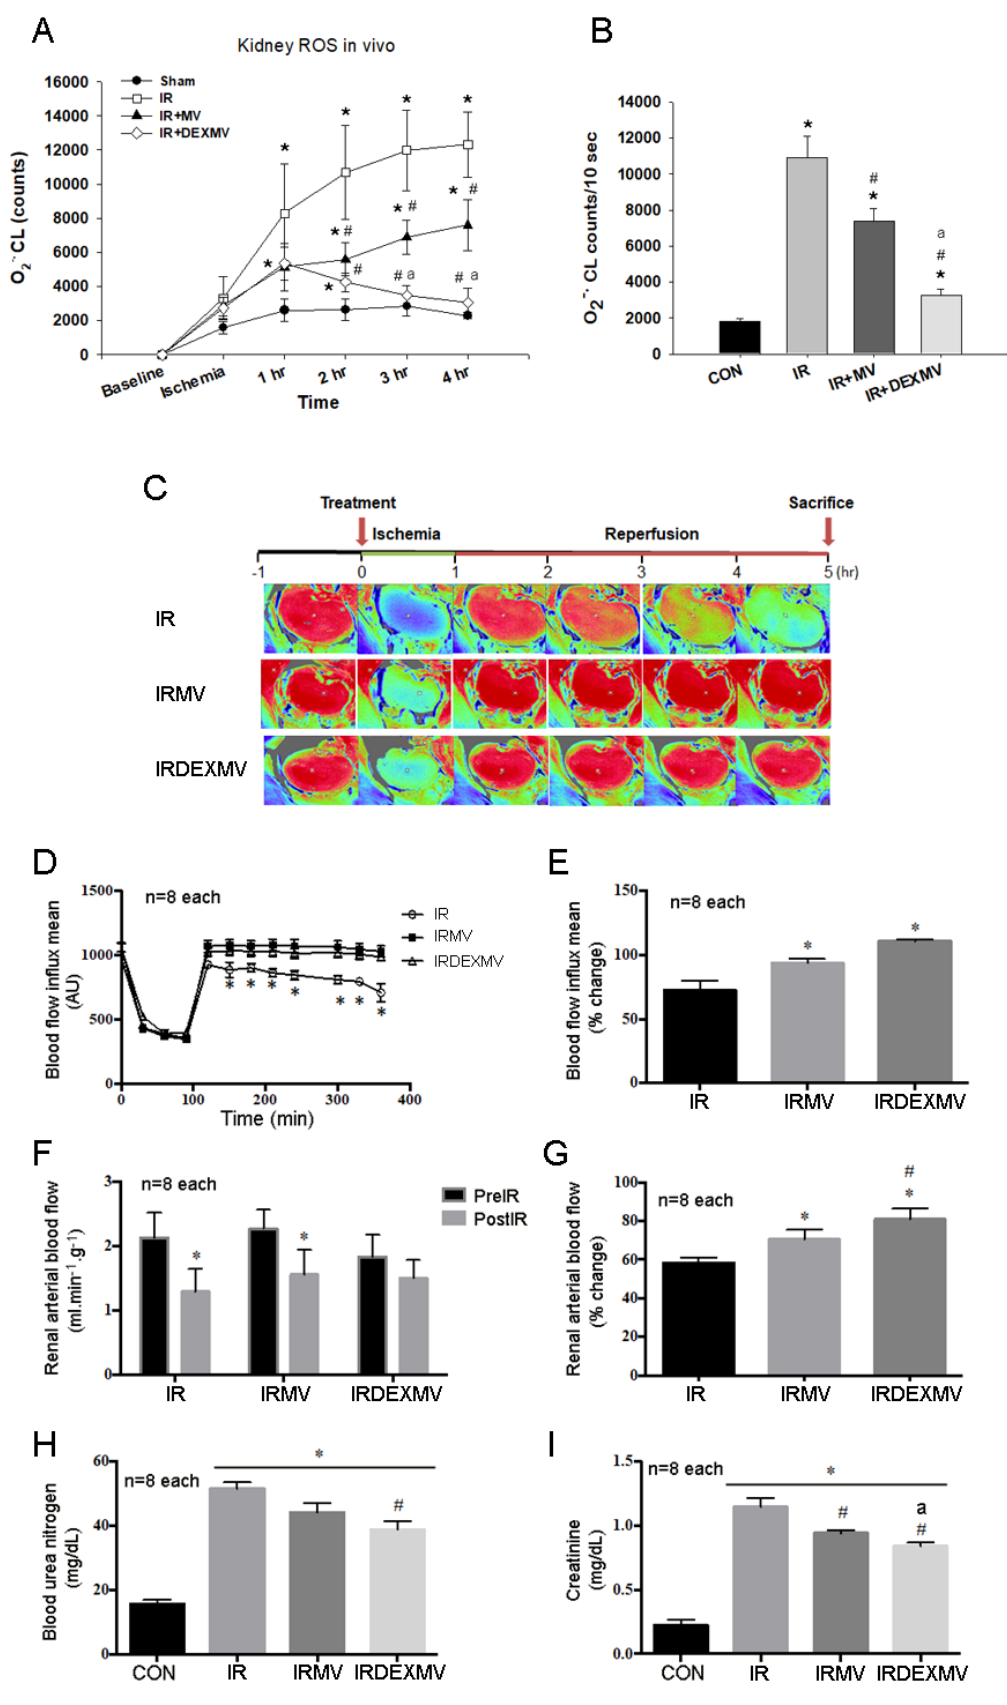
Figure 3. In response to renal IR injury, in vivo kidney ROS measurement was indicated in